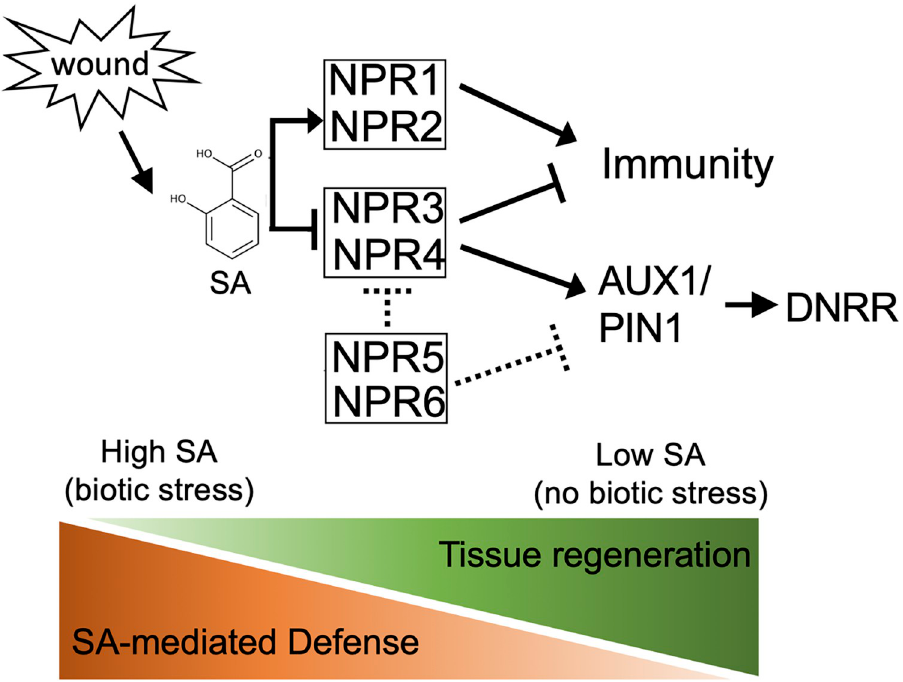
Fig 6. A model of SA-mediated balance of regeneration and immunity. A model depicting the role of SA signaling in DNRR. Wound-induced SA response acts through NPR3/4 to suppress the root regeneration. NPR5/6 plays an opposite role to NPR3/4. This SA-mediated suppression of DNRR may contribute to a molecular decision of regeneration or defense upon